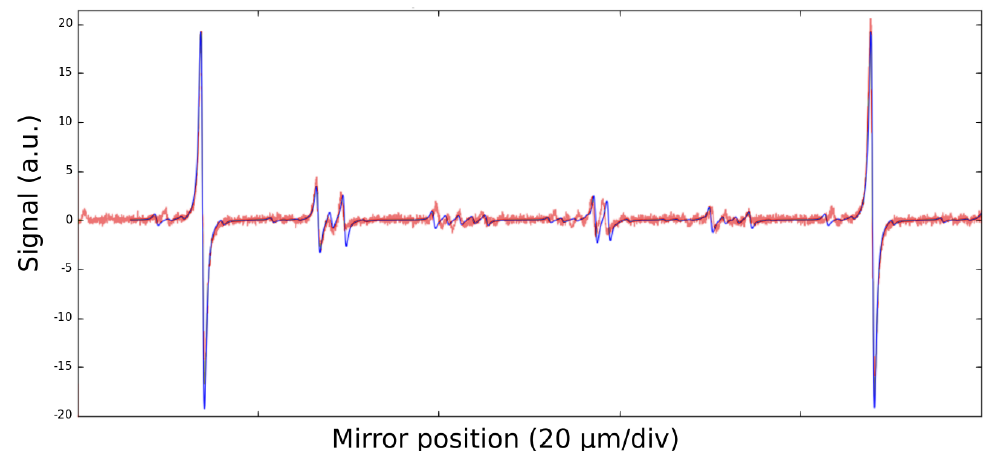
Figure 5. Comparison between experimental (yellow) and simulated spectrum (blue) of the BTC in the experimental condition (R m = 99%, R WGP = 97.9%), achieving a finesse value of 123. The simulation is performed with the Finesse [24] software, and by using the parameters Rm = 99%, RWGP = 97.9%.